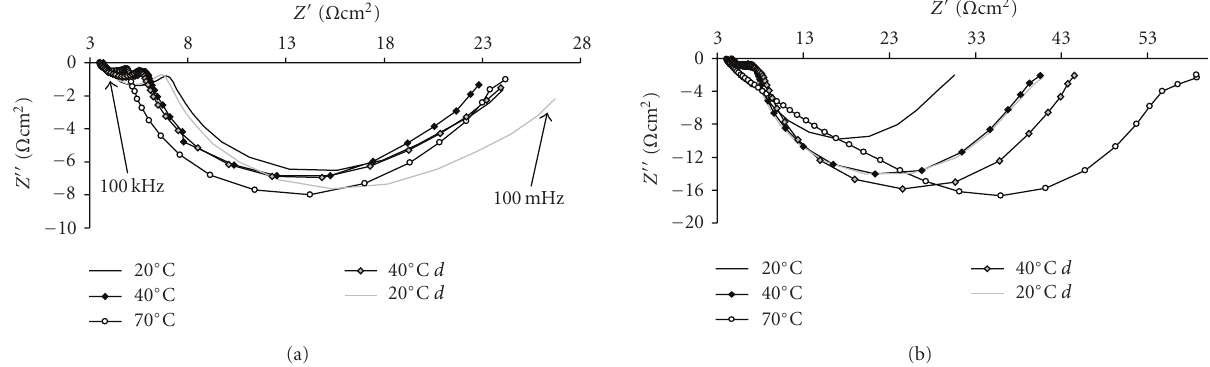
Figure 3: Typical Nyquist plots for the sintered cells at di ff erent temperatures: cell type L-S, measurement day 1 (a) and 78 (b). Letter “ d ” after the temperature value indicates the downward sweep of the temperature cycle. Z (cid:4) : real impedance; Z (cid:4)(cid:4) : imaginary